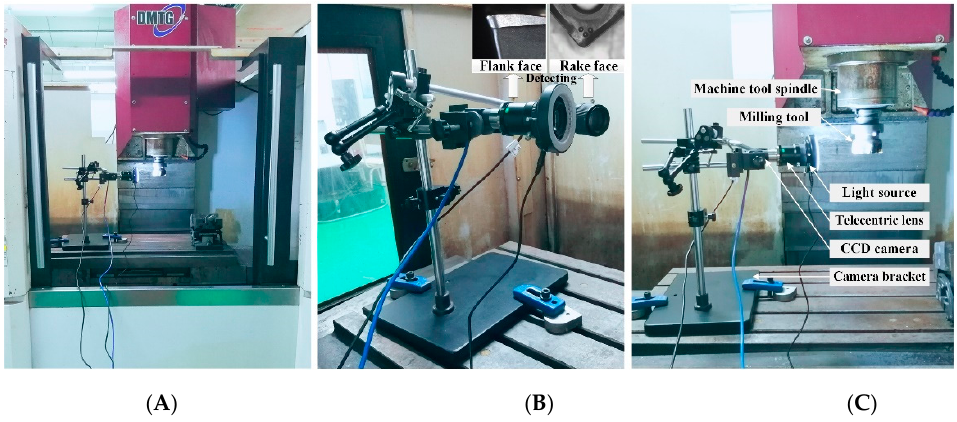
Figure 1. Process of matching the camera frame rate with the machine spindle speed. ( A , C ) Images of different numbered inserts at different speeds; ( B ) numbered picture of inserts for face milling cutter.